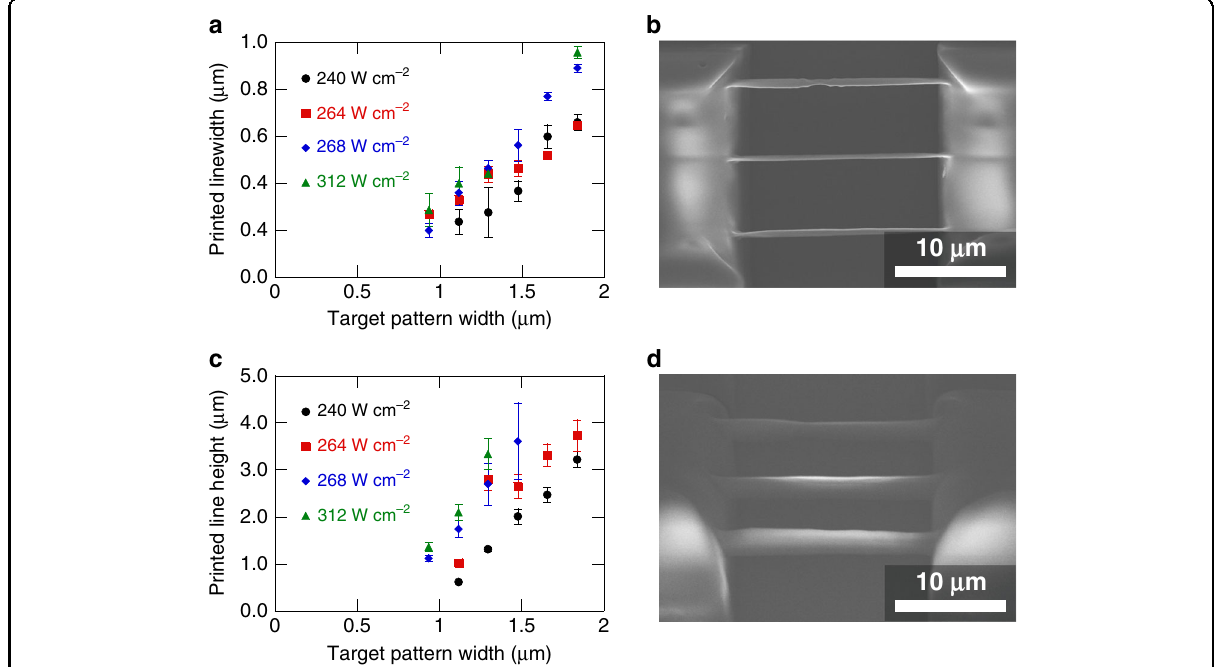
Fig. 4 Printing of suspended line structures. a Printed linewidths as a function of projected pattern width at the print plane. Each point represents an average of 3 lines printed suspended across preprinted supports. Error bars represent one standard deviation of measurements. b Example printed structure from a for target 1.296µm width lines printed with 264 W cm − 2 . c Printed line heights as a function of projected pattern width at the print plane. Each point represents an average of 3 lines printed suspended across preprinted supports. View angle is at 45 ˚ from substrate normal. Error bars represent one standard deviation of measurements. d Example printed structure from c for target 1.116µm width lines printed with 264 W cm − 2 . All line prints were performed with a stage travel speed of 100 µm s − 1 and a DMD pattern exposure of 5